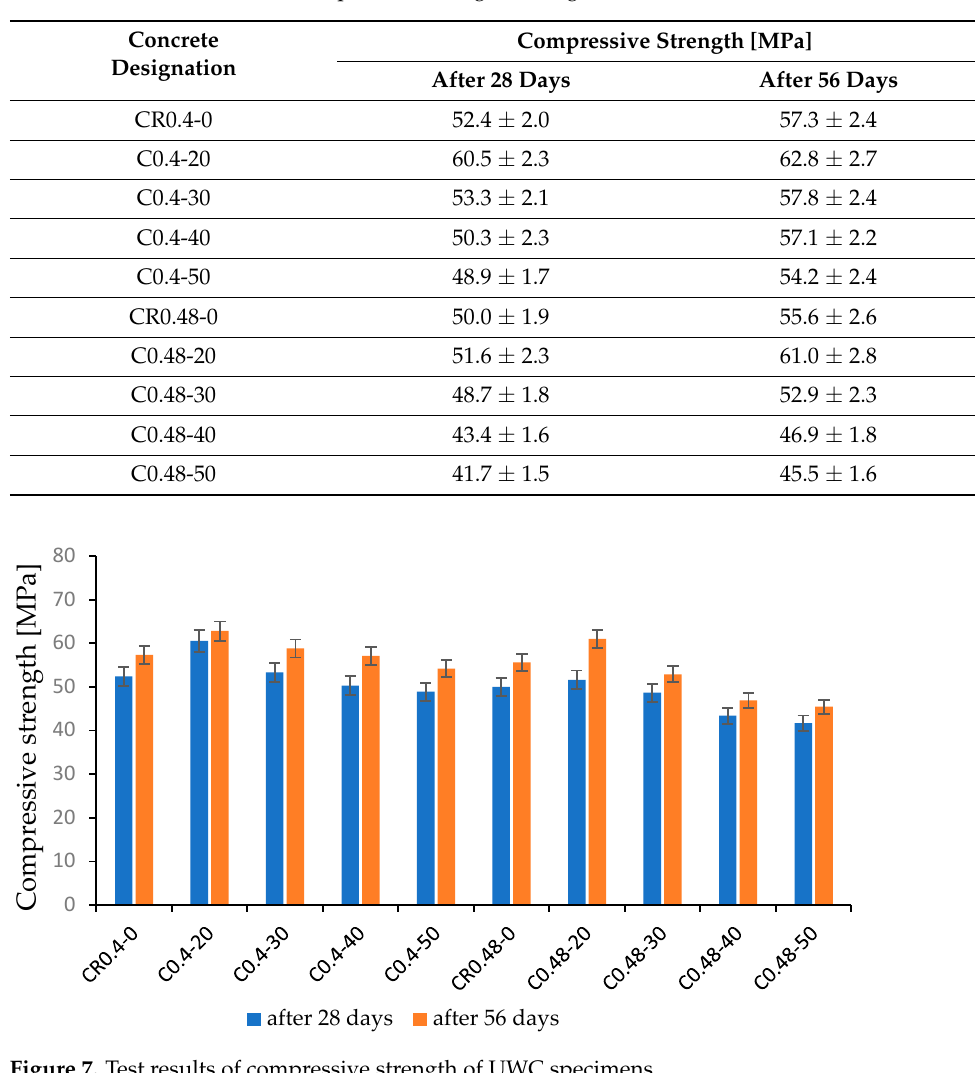
Figure 7. Test results of compressive strength of UWC specimens .